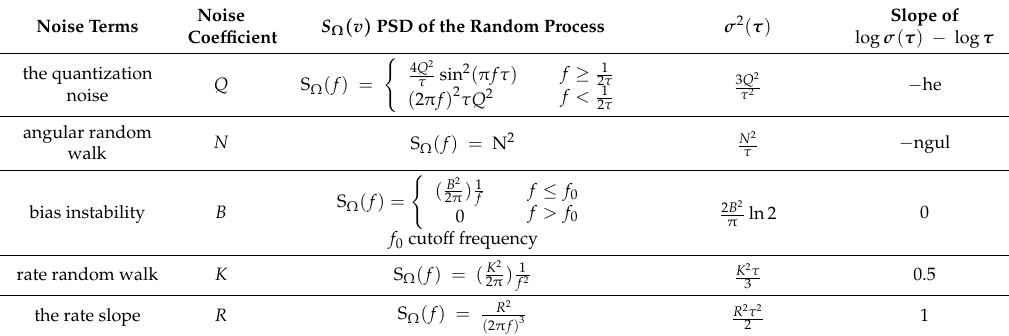
Table 1. Relationship between noise terms, Allan variance and τ